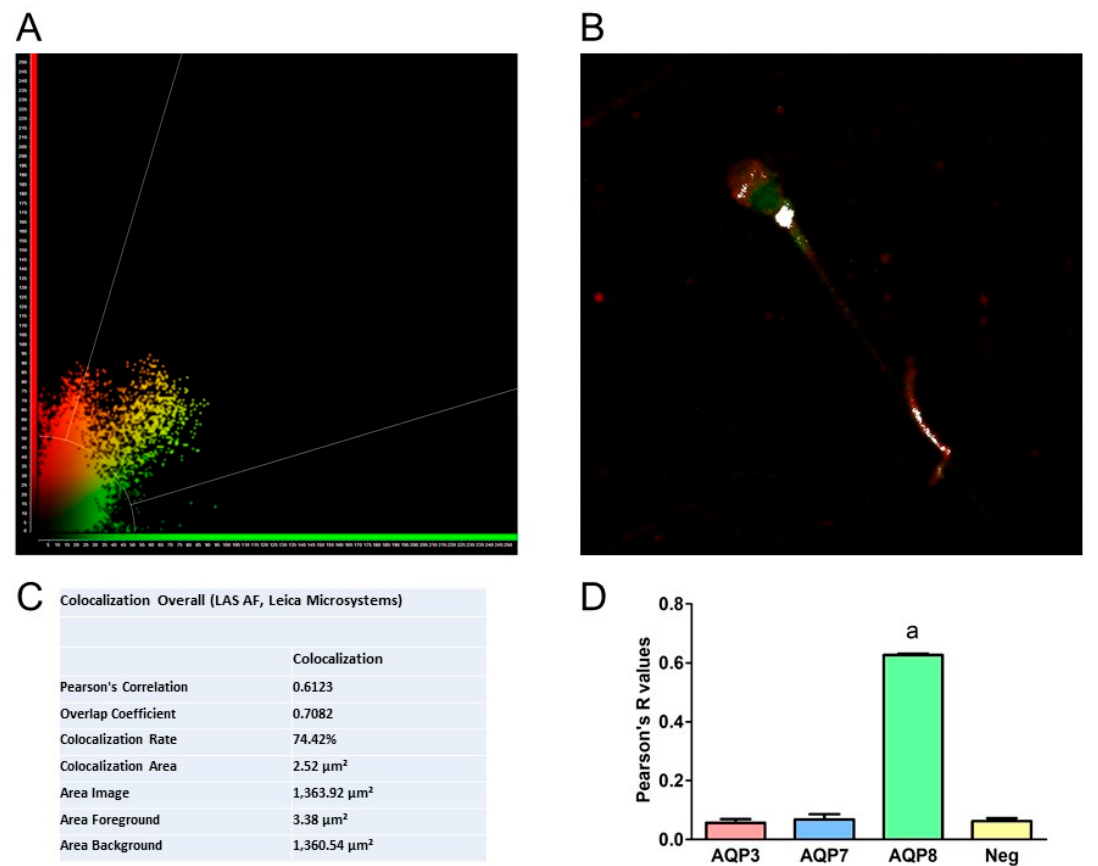
Figure 3. Representative colocalization analysis using the Leica LAS-AF image system. ( A ) Pixels distribution scatter plot: colocalized yellow pixels between the two diagonals, red (AQP8) pixels in ordinate and green (HPV) pixels in abscissa. ( B ) Leica LAS-AF software generates an image of colocalized pixels, highlighted in white, superimposed on an RGB-merge of two channels. ( C ) Overall colocalization values obtained from the representative colocalization analysis using the Leica LAS-AF image system. ( D ) Statistical analysis of Pearson’s coefficient R values was obtained from at least 6 different double immunofluorescence experiments with anti-HPV antibody and anti-AQP3, AQP7, or AQP8 antibodies. Negative controls (Neg) were also analyzed. a, p < 0.0001 vs. AQP3, AQP7 and Neg (ANOVA, followed by Newman–Keuls’s Q test).